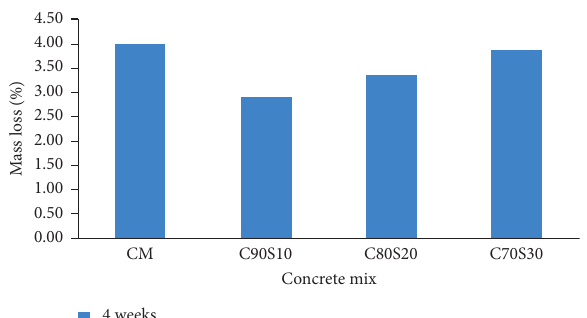
Figure 10: Mass changes of concrete specimens immersed in 5% sulphuric acid solution for 4 weeks.